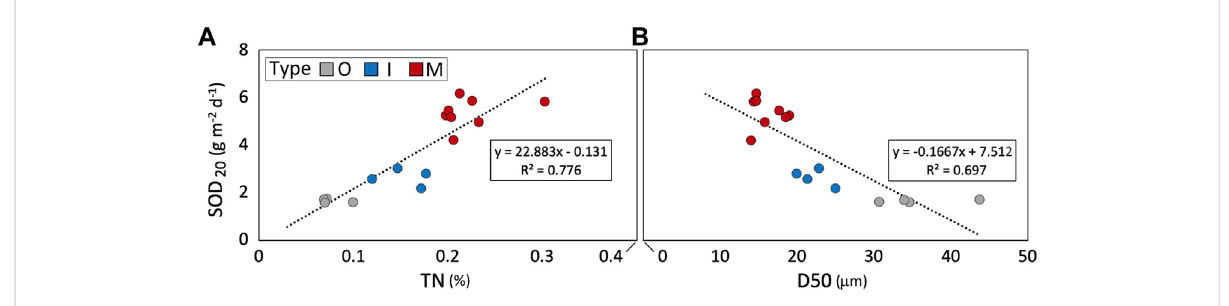
FIGURE 8 RegressionplotbetweenmeanSOD 20 and (A) TNconcentrationand (B) D50.Thethreetypesofsedimentsarehighlightedwithdifferentcolors.